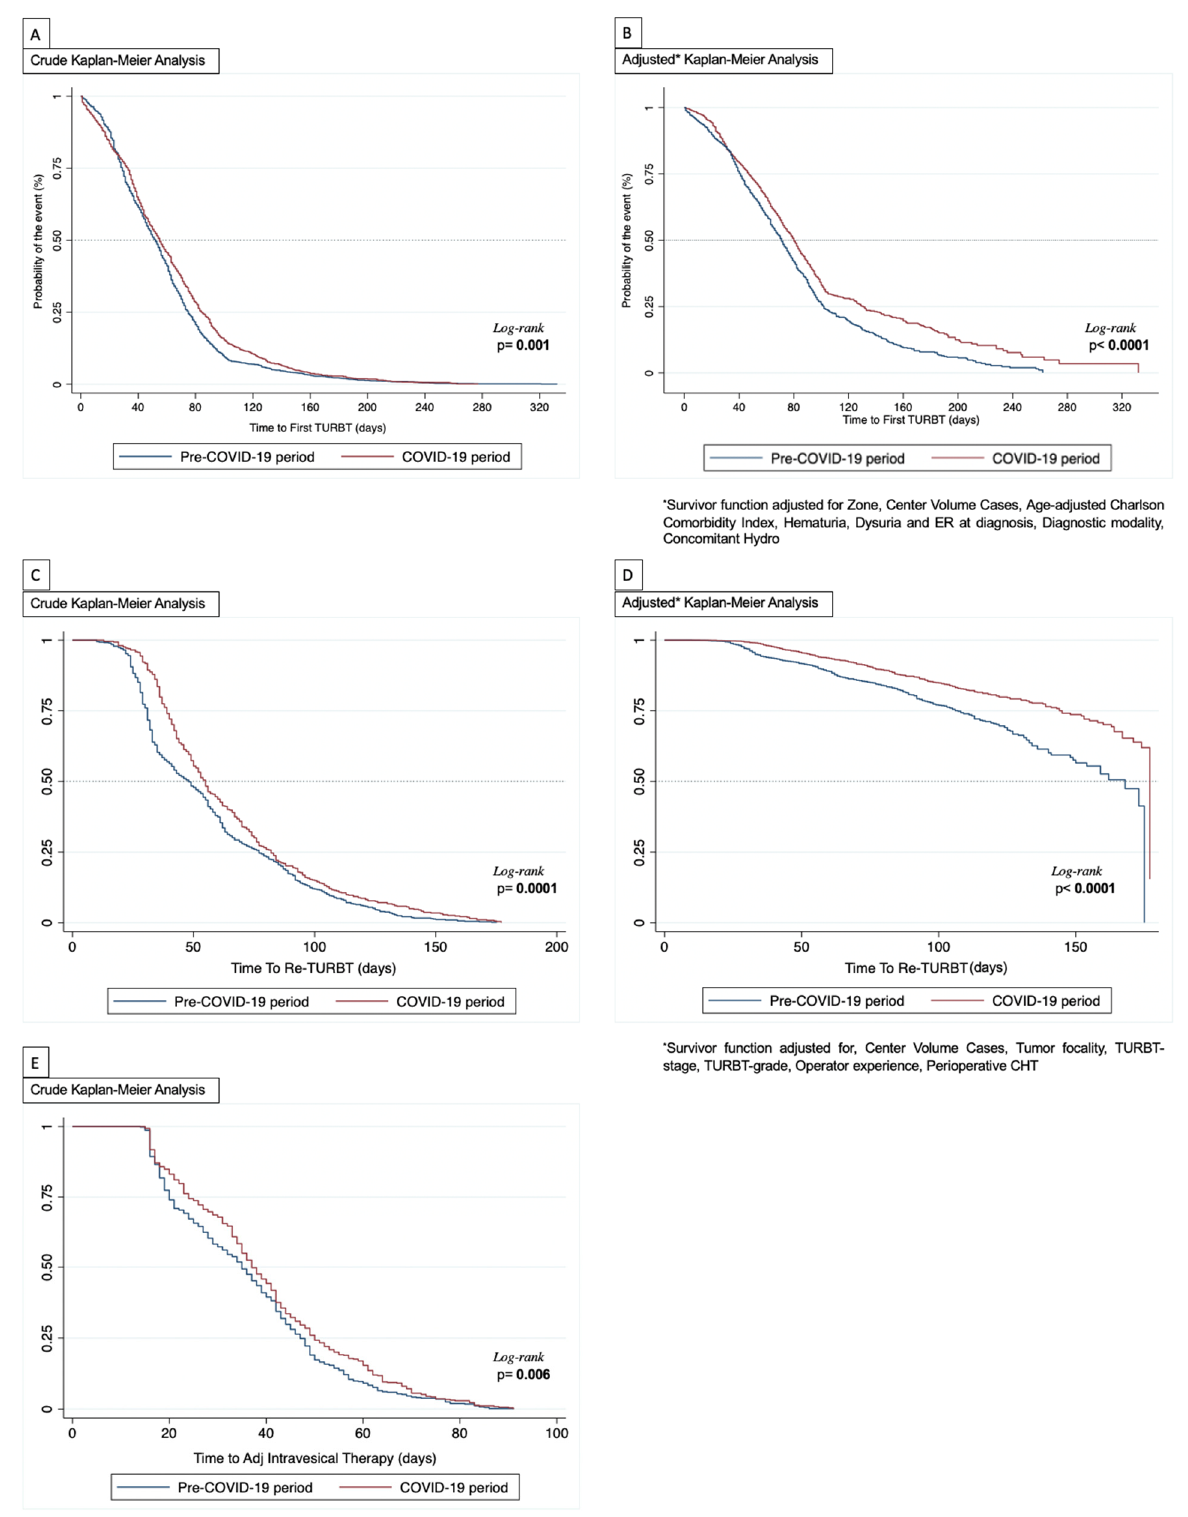
Figure 1. Kaplan–Meier analysis. ( A ) Crude analysis for time to first TURBT; ( B ) Adjusted analysis for time to first TURBT; ( C ) Crude analysis for time to Re-TURBT; ( D ) Adjusted analysis for time to Re-TURBT; ( E ): Crude analysis for time to adjuvant intravesical therapy.